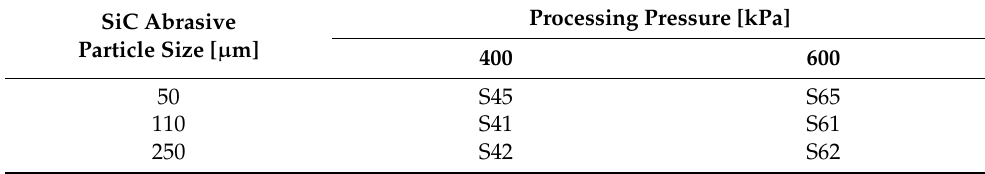
Table 2. The parameters of abrasive blasting